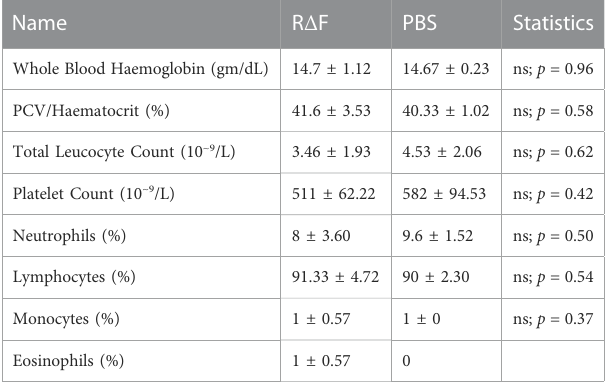
TABLE 1 Haematology and Coagulation Parameters in mice injected with R Δ F NPs and